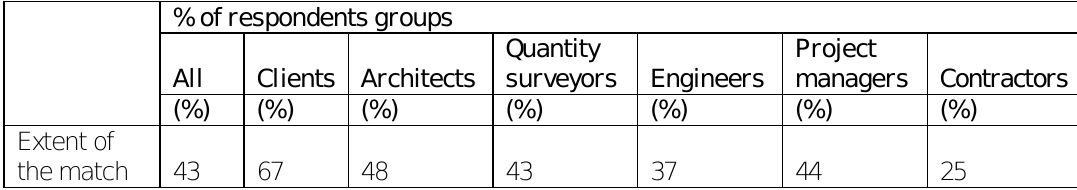
Table 2: Perceptions of the extent to which the procurement team always and sometimes attempt to match client needs with the characteristics of different procurement